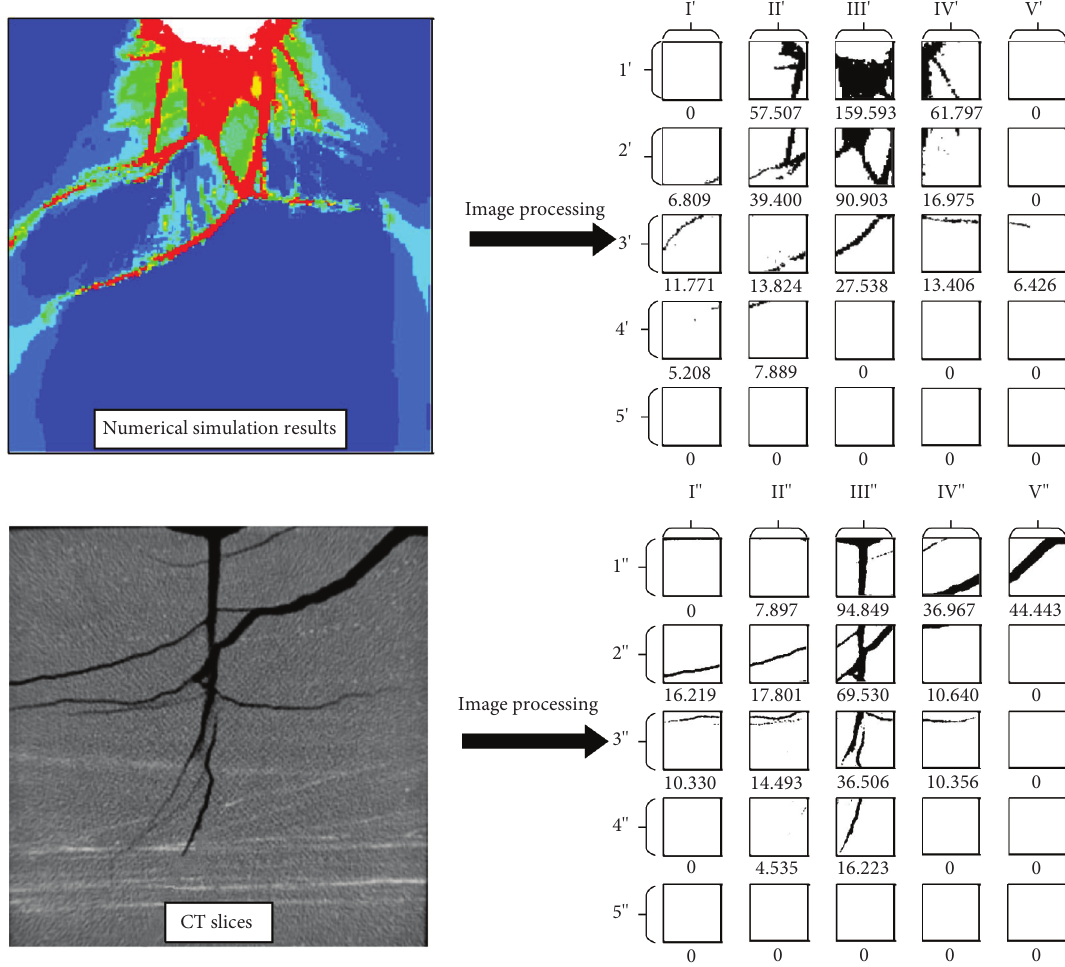
Figure 4: Image processing results of AWJ impacting rock.